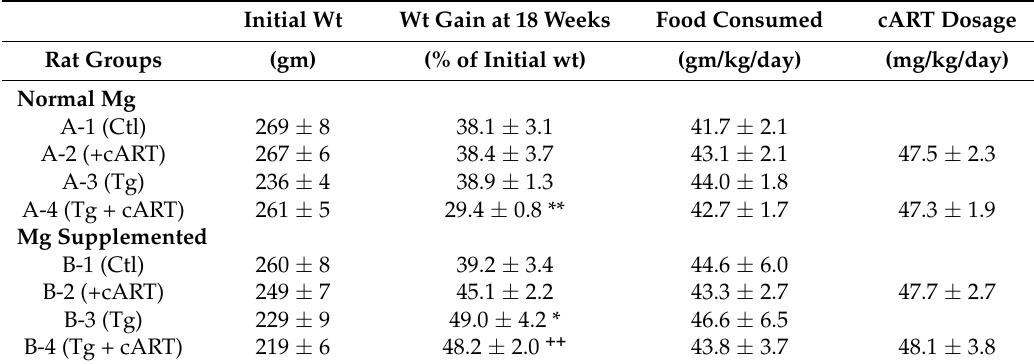
Table 1. Effect of cART treatment for 18 weeks on food consumption and weight gain of control and HIV-Tg rats receiving normal Mg or Mg supplemented